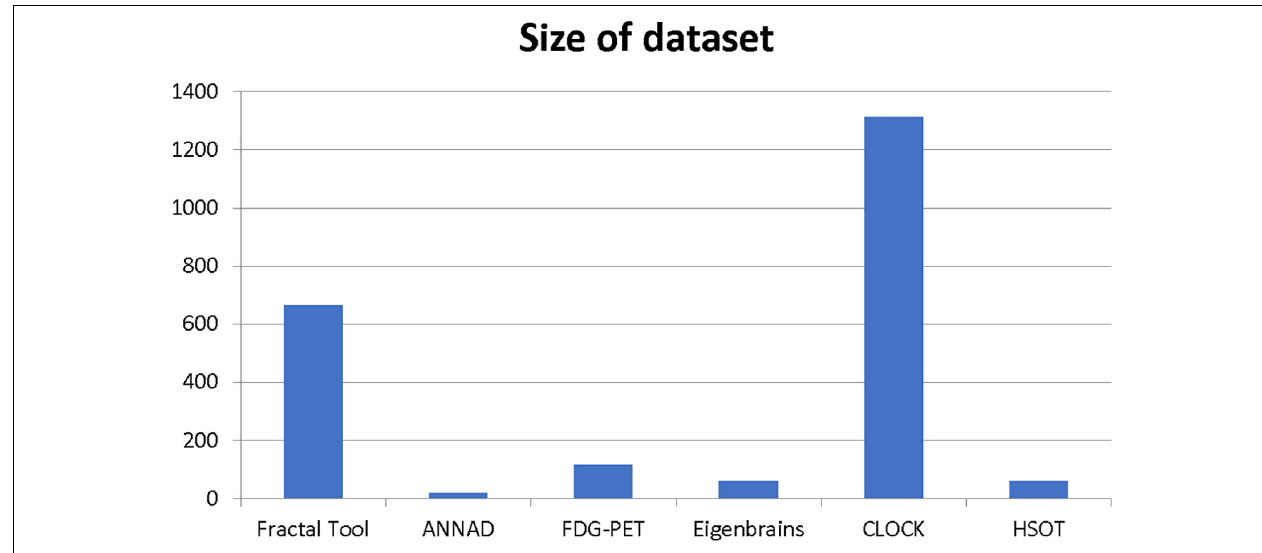
FIGURE 21 | Size of the dataset of the most efficient